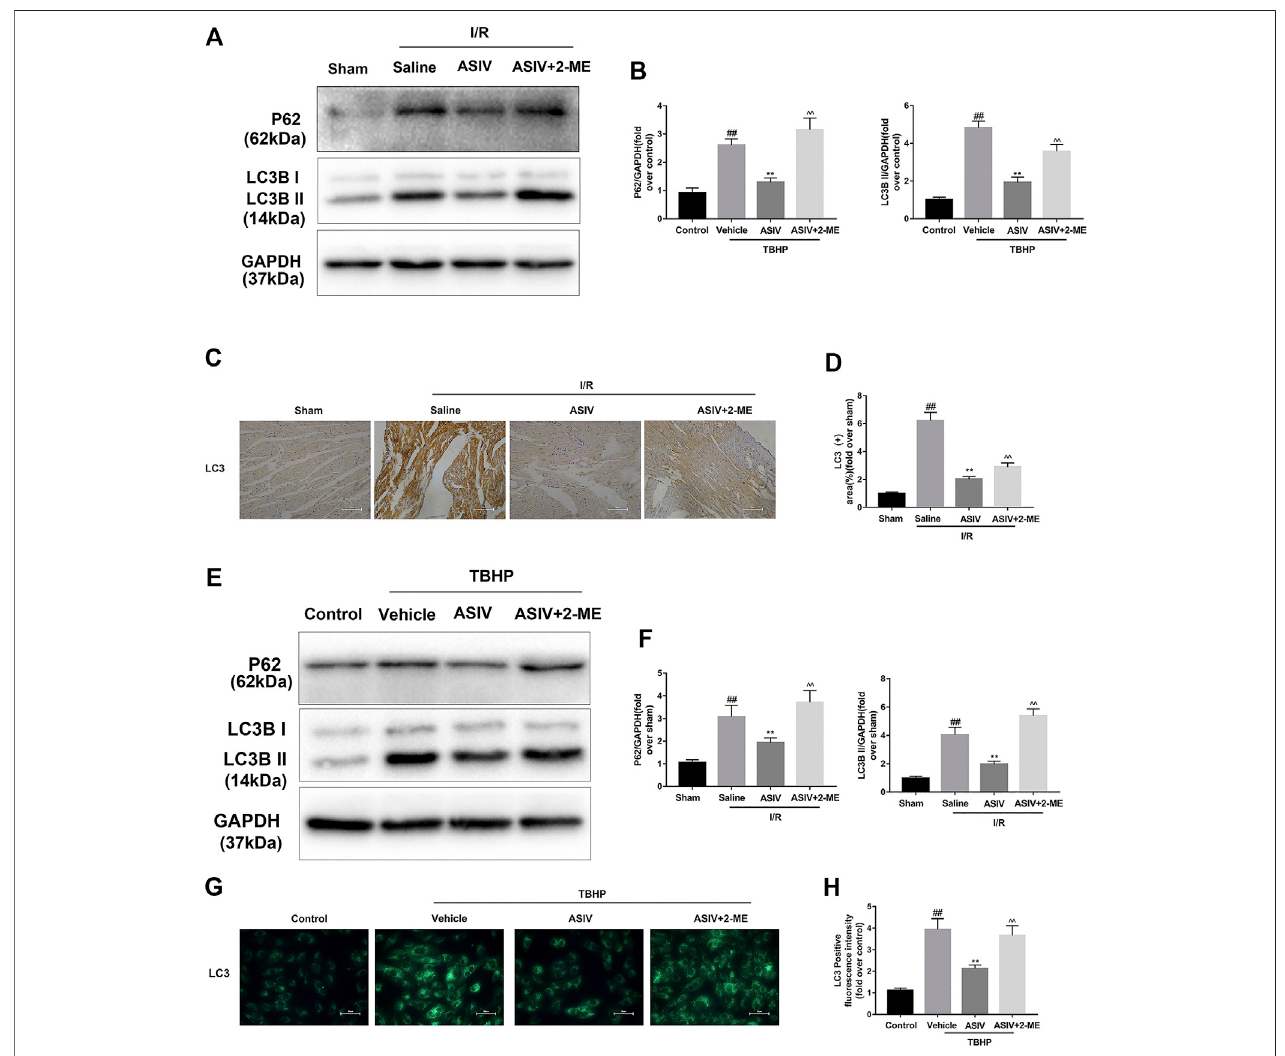
(cid:129) − FIGURE7| O2 accountsforASIV-mediated regulationofautophagyinmyocardialI/Rinjury.Miceweretreatedwith2-ME(20 mg/kg;i.p.)andASIV(20 mg/kg; i.p.) during reperfusion, then killed at 4h after reperfusion for detection of (A, B) Western blot indicating expression of LC3 and P62 proteins. (C, D) Representative IHC images of LC3B in mice myocardial cross sections ( × 400), (E, F) Western blot indicating expression of LC3B and P62 proteins, (G, H) Representative immuno fl uorescence images of H9C2 loaded with LC3, scale bar: 50 μ m n (cid:2) 6. Values are expressed as the means ± SD. # p < 0.05 compared with the sham or control group, * p < 0.05 compared with the I/R or TBHP group, ^ p < 0.05 compared with the ASIV group (each test was repeated three times).